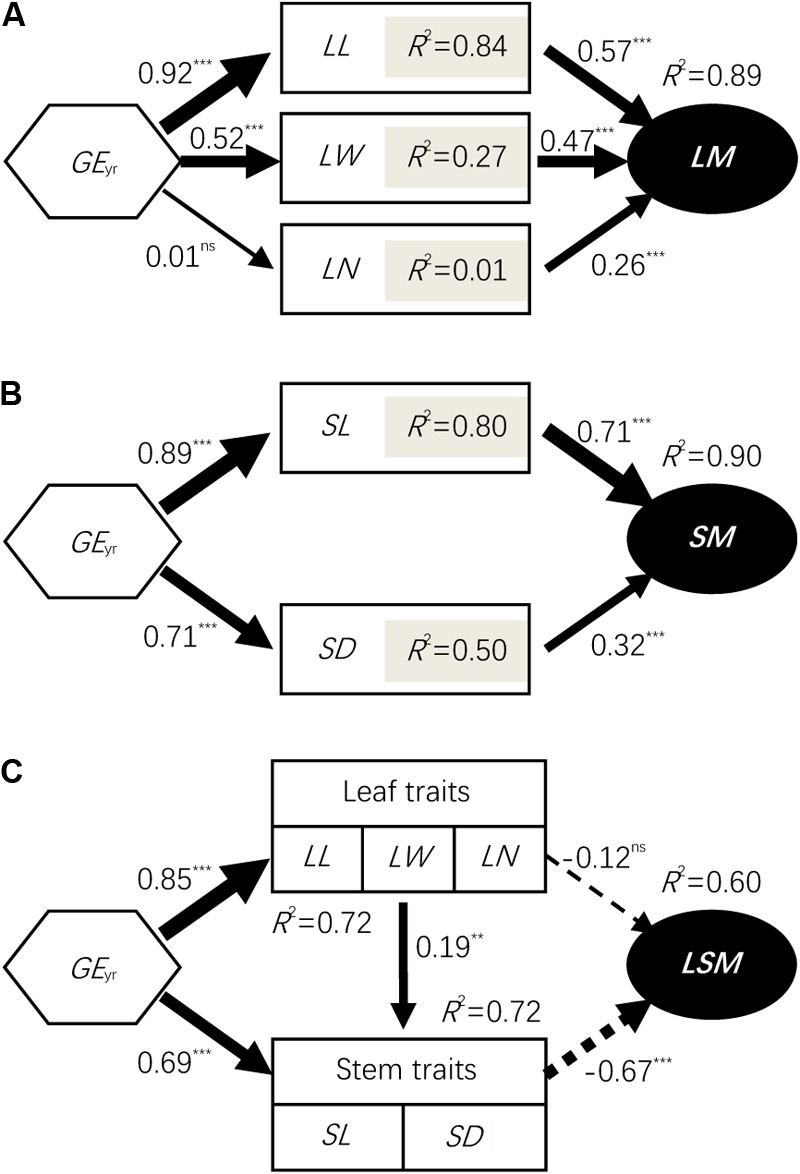
Structural equation modeling (SEM) results for the grazing exclusion effects on biomass accumulation (A,B) and allocation (C) at the individual level. Values associated with arrows represent standardized path coefficients. Solid and dashed arrows represent positive and negative paths, respectively, in a fitted SEM depicting the impact of variables on stem length decline. R2 values associated with response variables indicate the proportion of variation explained by relationships with other variables. Symbols: ∗∗∗represents P < 0.001; ∗∗represents P < 0.01; ns represents P > 0.05. LM, leaf mass; SM, stem mass; LSM, leaf to stem mass ratio; AM, aboveground mass; PH, plant height; LL, leaf length; LW, leaf width; SL, stem length; SD, stem diameter; and LN, leaf number; GEyr, number of years of grazing exclusion.